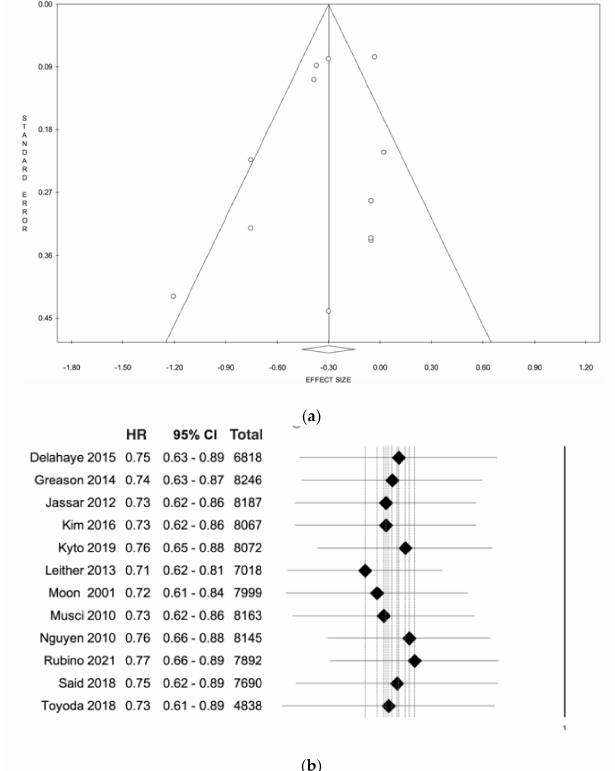
Figure 3. ( a ) Funnel plot to assess the publication bias. No publication bias was reported relating to the long-term survival. Circles define the position of each study in the funnel plot ( b ) Forest plot of the leave-one-out analysis comparing the effect of the use of a mechanical and biological prosthesis. Abbreviation: HR, hazard